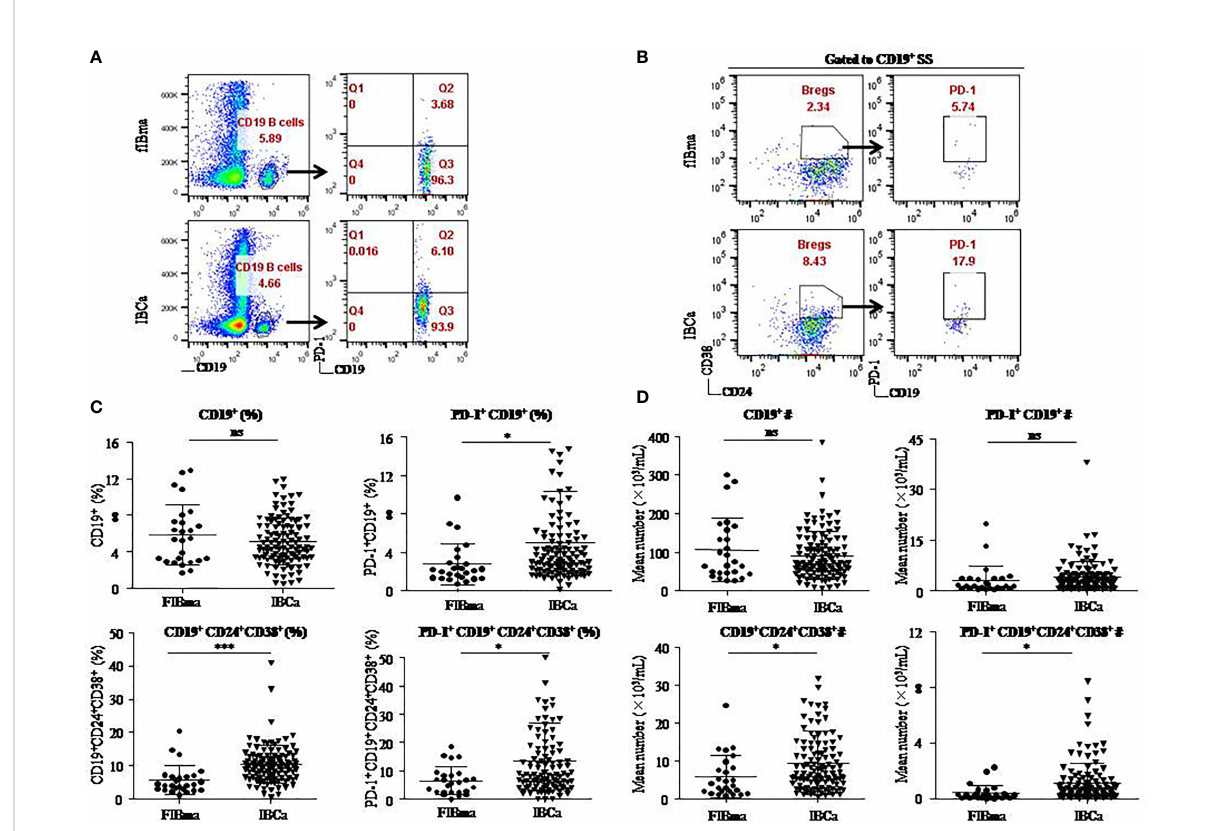
FIGURE 1 CD19 + CD24 + CD38 + B lymphocytes predominated in PBMCs of IBCa patients. The percentage and the absolute number of CD19 + B-cell subsets were measured in IBCa patients (n = 114) and FIBma patients (n = 26). PBMCs were isolated from peripheral blood and stained with CD19-BV605, CD24-PE-Cy7, CD38-BV421, and PD-1-FITC for fl ow cytometry, as described in “ Materials and methods ” . Representative fl ow cytometry dot plot of PD-1 expression in total CD19 + B cells (A) and CD24, CD38, and PD-1 expression in CD19 + B cells or CD19 + CD24 + CD38 + B cells (B) . Scatter plots showing the percentage of CD19 + B-cell subsets in FIBma patients and IBCa patients. A signi fi cant increase in the frequency of PD-1 + CD19 + B cells, CD19 + CD24 + CD38 + B cells, and PD-1 + CD19 + CD24 + CD38 + B cells was observed in IBCa patients compared to FIBma patients ( P = 0.035, P = 0.0001, P = 0.010, respectively) (C) . The absolute number of CD19 + B-cell subsets in FIBma patients and IBCa patients. The absolute numbers of CD19 + CD24 + CD38 + B cells and PD-1 + CD19 + CD24 + CD38 + B cells were signi fi cantly higher in IBCa patients than in FIBma patients ( P = 0.038 and P = 0.017, respectively) (D) . All values show the means ± SEM. Data were analyzed by unpaired Student ’ s t -test. ns, not statistically signi fi cant. * P < 0.05 and *** P <